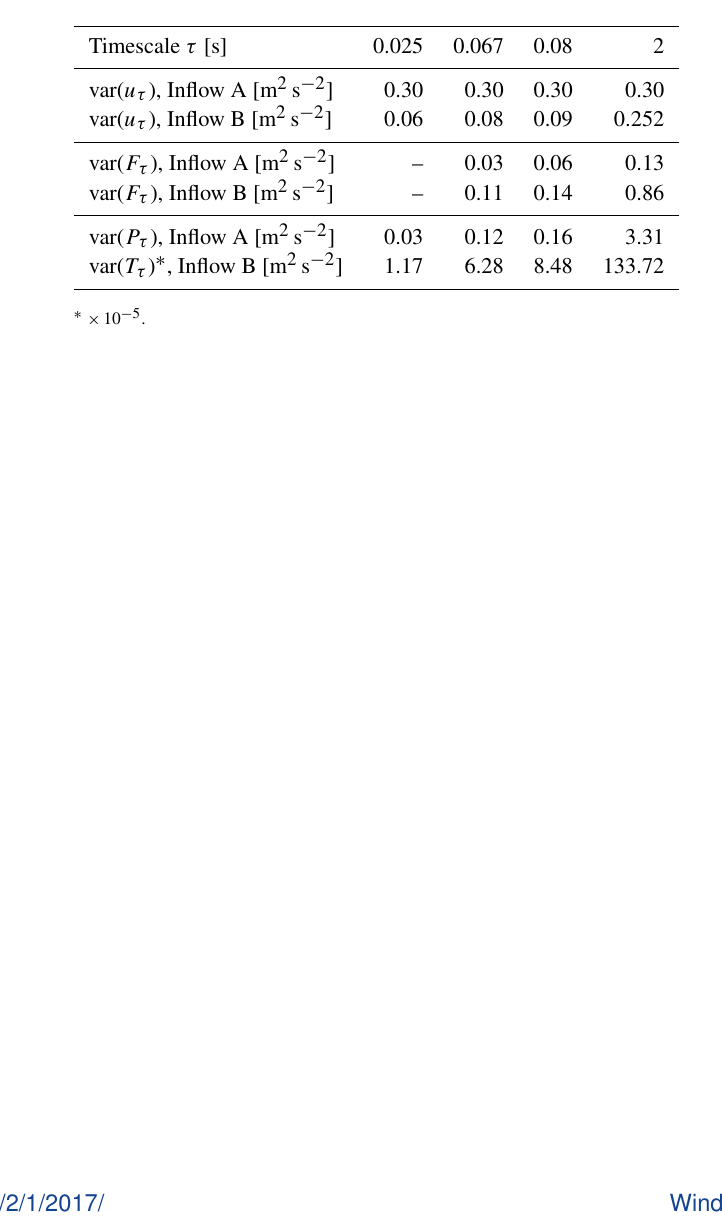
Table B2. Variances of each increment time series for the experimental data. var( u τ ) corresponds to the graphs shown in Fig. 7, var( F τ ) to the graphs in Fig. 8, var( P τ ) and var( T τ ) to p ( P τ ) and p ( T τ ), respectively, as shown in Fig.